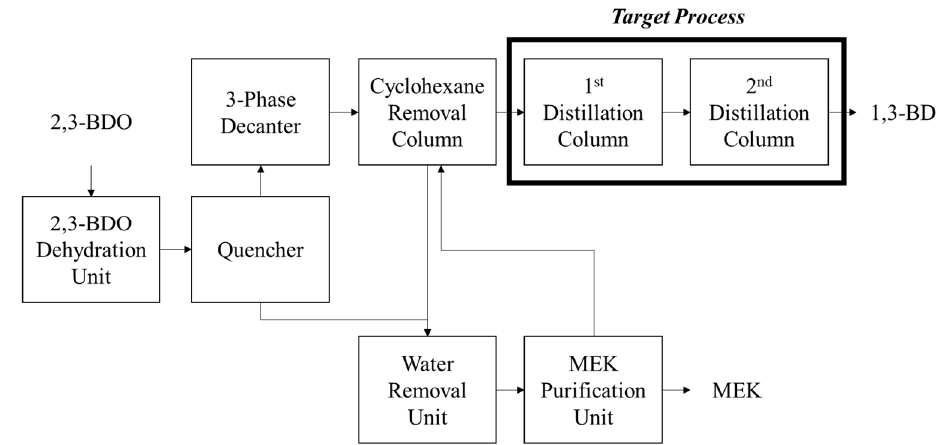
Figure 1. Block flow diagram of the process used to produce 1,3-Butadiene (1,3-BD) and methyl ethyl ketone (MEK) [11].